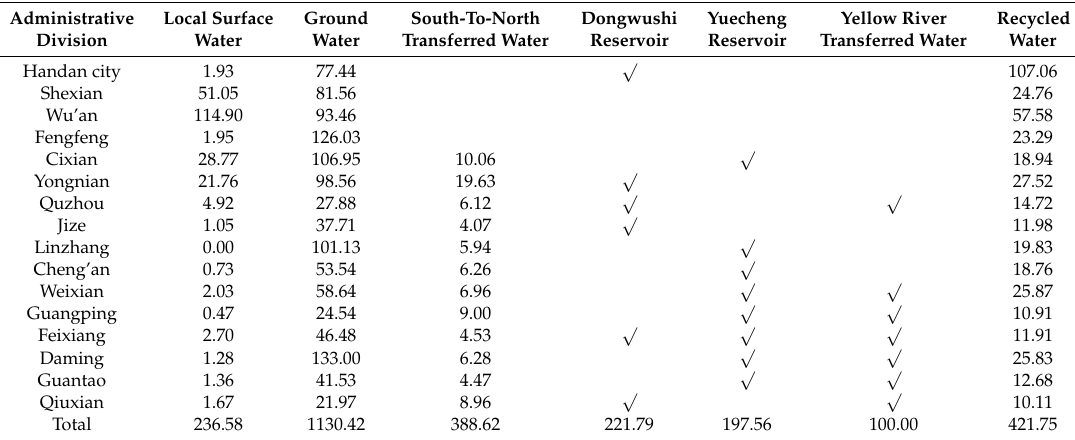
Table 2. The amount of water supply in 2030 (10 6 m 3